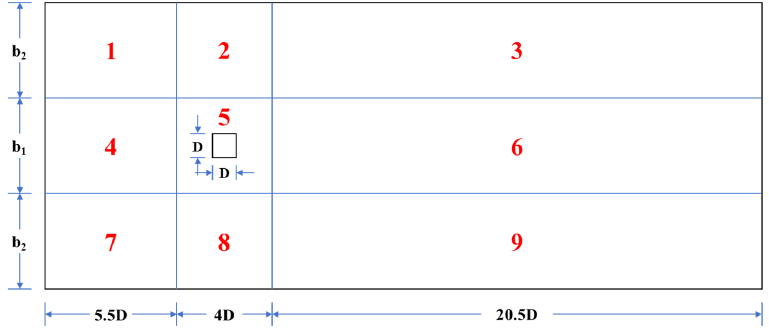
Figure 2. The location of nine zones for grid generation.